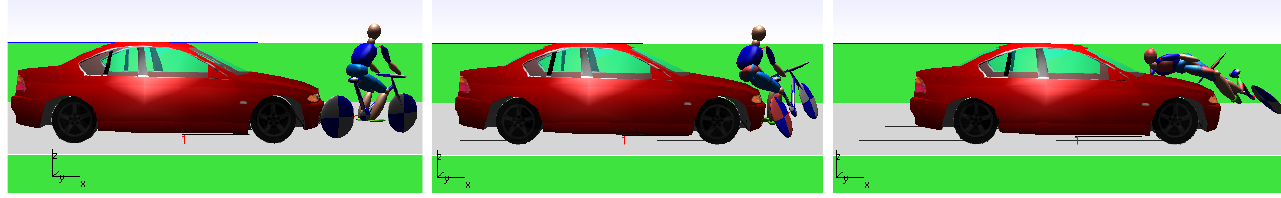
Figure 5. Example of a bicycle collision simulation (collision angle 30°).